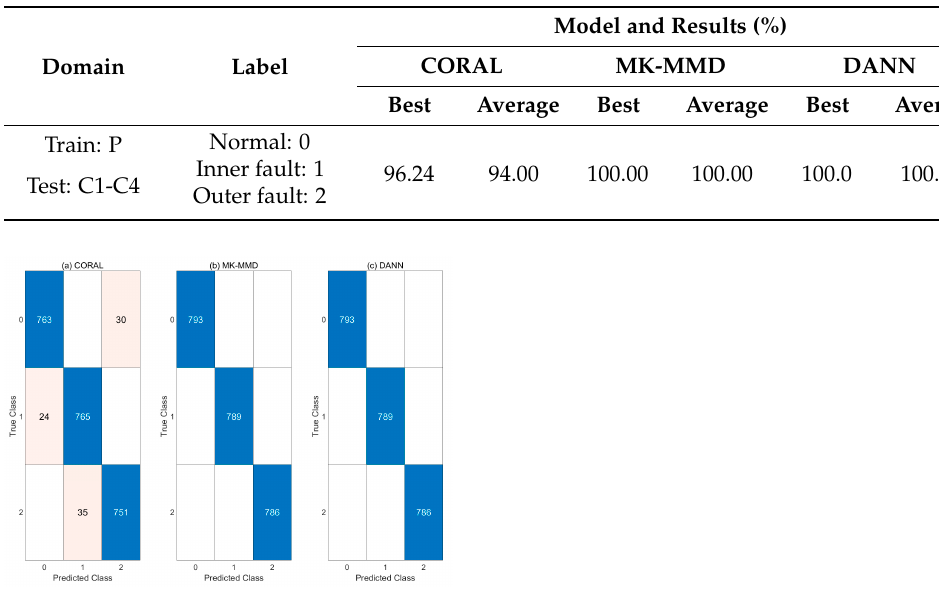
Table 6. Classification results of case 3.